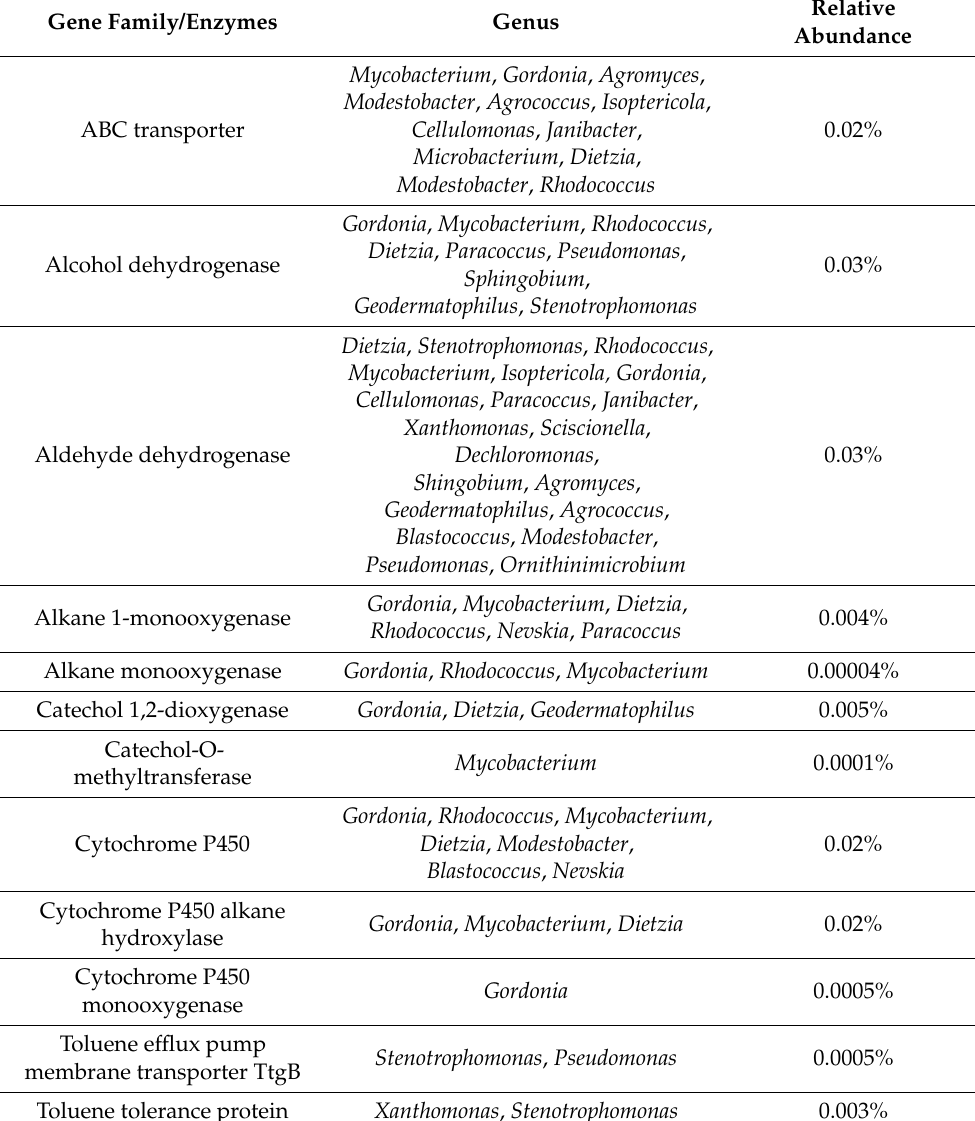
Table 3. Main gene families, enzymes, and pathways directly or indirectly involved in hydrocarbons degradation, as well as associated genera identified in metagenomic data of SGM. Genes’ relative abundance represents the proportion of the specific gene compared to the total number of functional genes. Pathways’ relative abundance represents the proportion of the specific pathway compared to the total number of